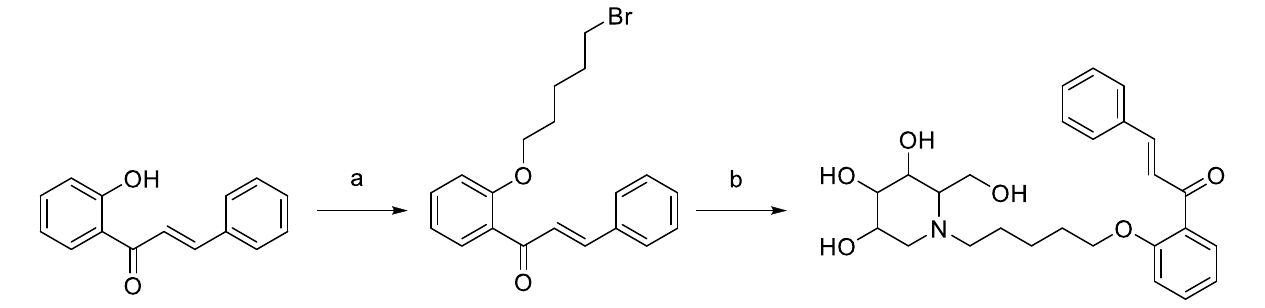
Figure 1. Synthesis scheme of intermediate and target products of DC-5. Reagents and conditions: ( a ) K 2 CO 3 , acetone, dibromopentane, 65 °C, overnight; ( b ) 1-DNJ, K 2 CO 3 , DMF, 85 °C, 6 h.